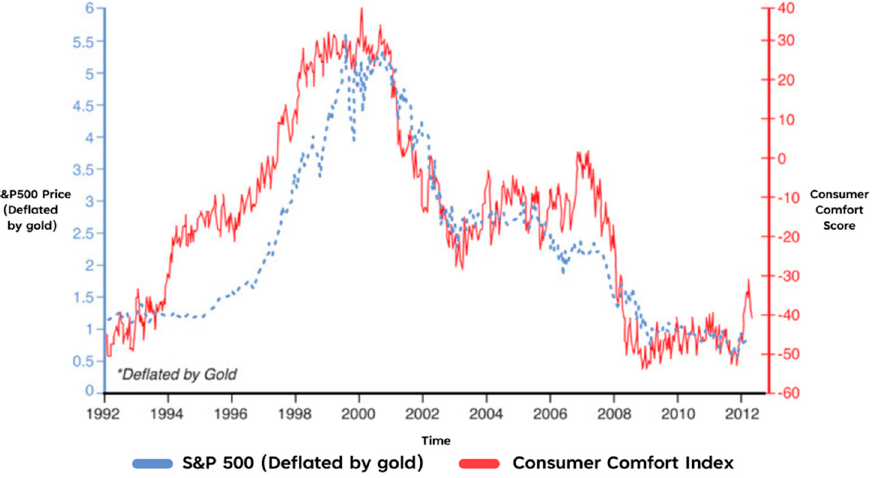
Figure 2. The Bloomberg Consumer Comfort Index versus the S&P 500 (deflated by gold), 1992–2012, [7].